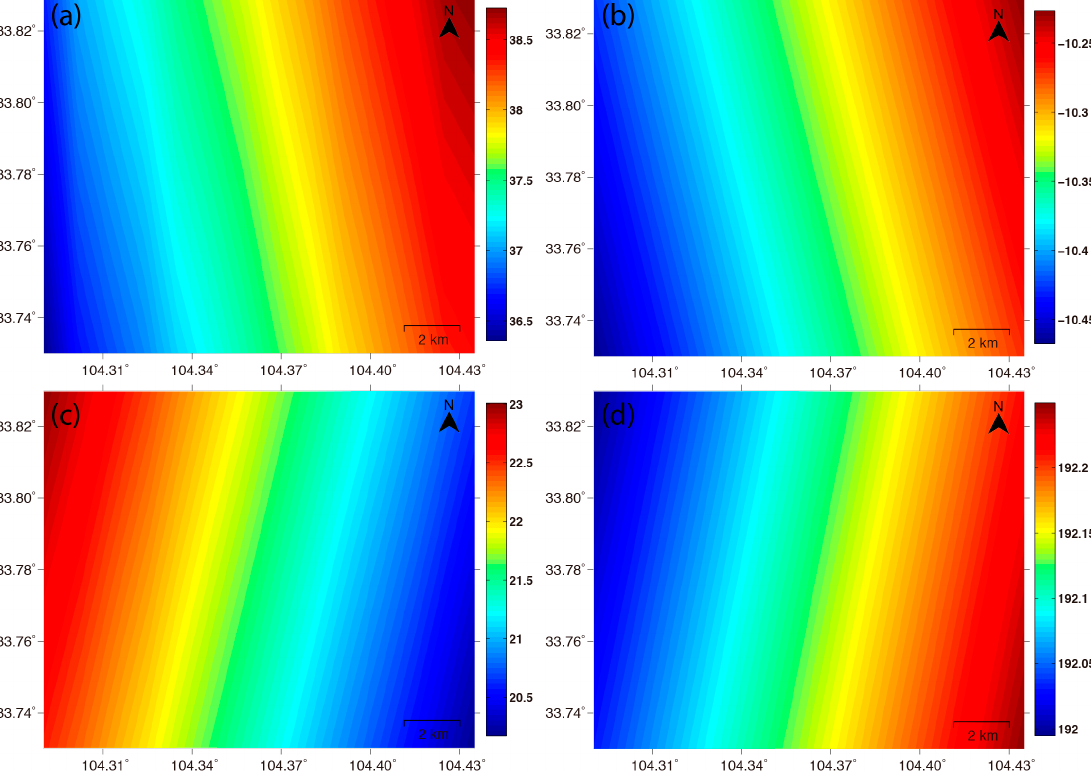
θ and the azimuth angle